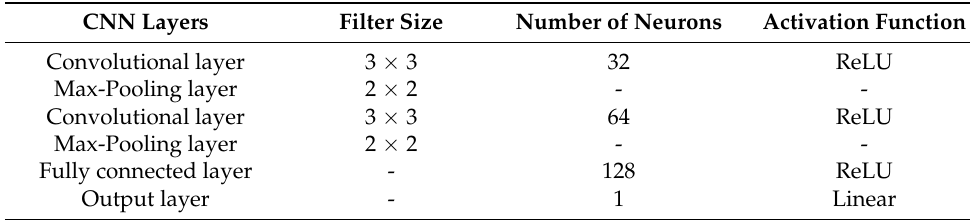
Table 2. Structure of CNN in the CNN-LSTM model.